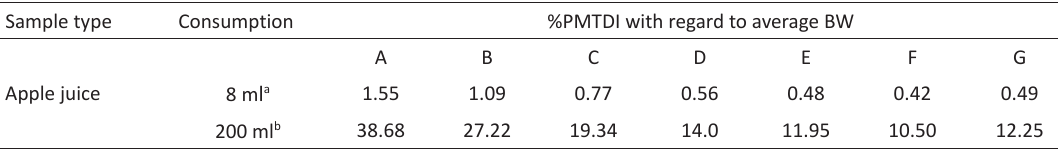
Table 4. PMTDI values for patulin with regard to individual age groups Sample